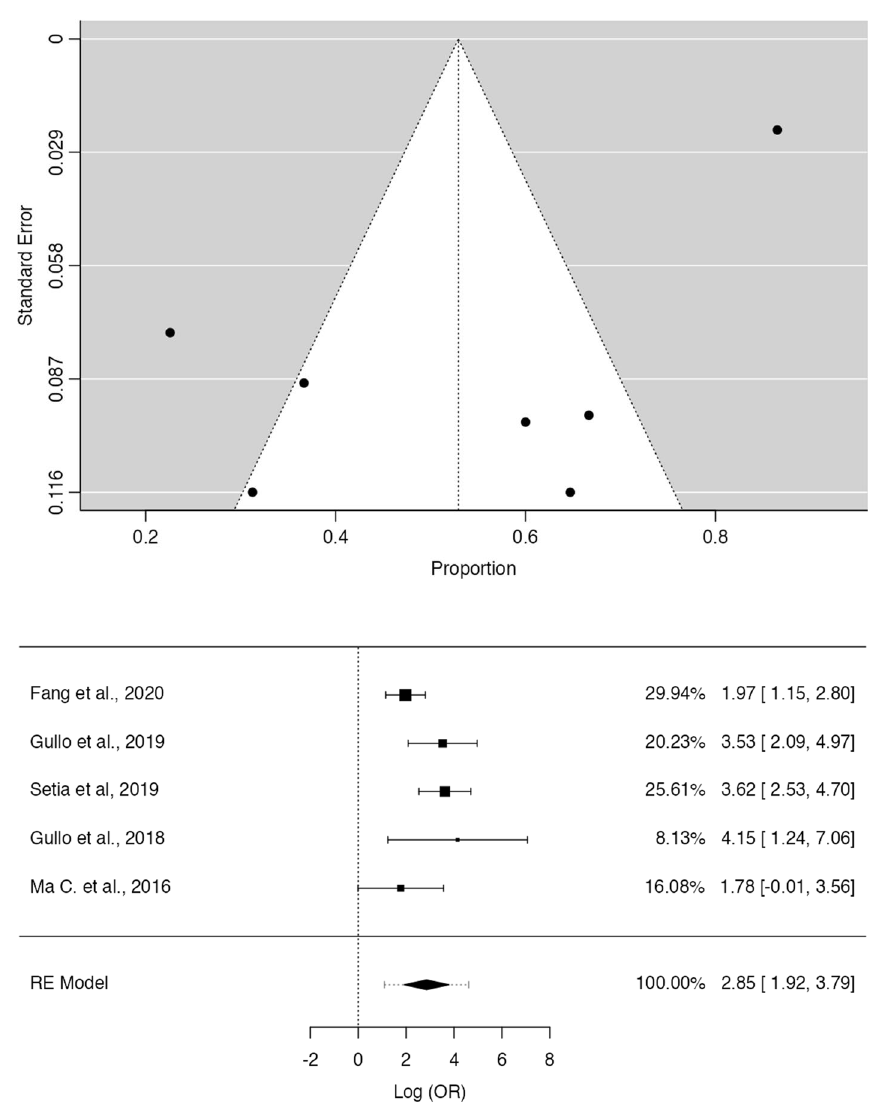
Fig. 7 Funnel-plot on the proportion of EBV positivity rate on GCLS